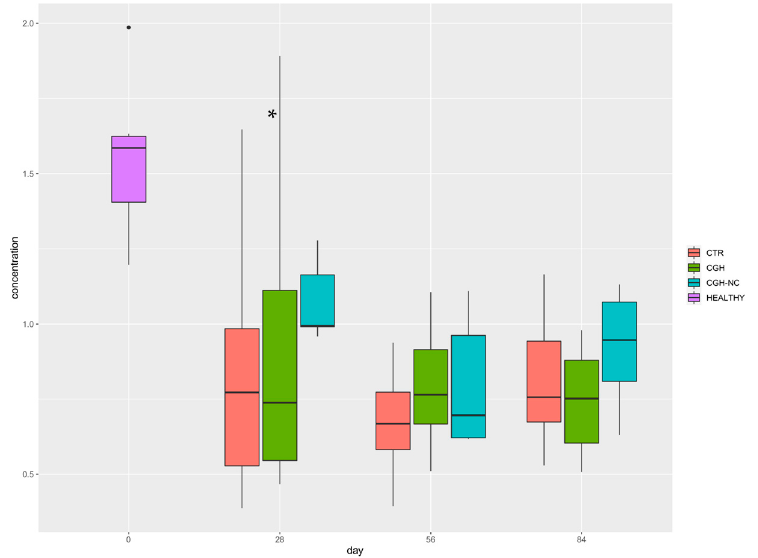
Figure 8. Heat map representing “synovial membrane” changes in the different treatment groups at different survival times and the frequency of occurrence at different survival times. Clearer colours result in an increase of the frequency of each stage of the disease. Orange lines are included on the maps to facilitate the understanding of the behavior of each treatment and the survival time. CGH-NC administration led to less inflammatory changes compared to the remaining treatment groups ( p < 0.01).